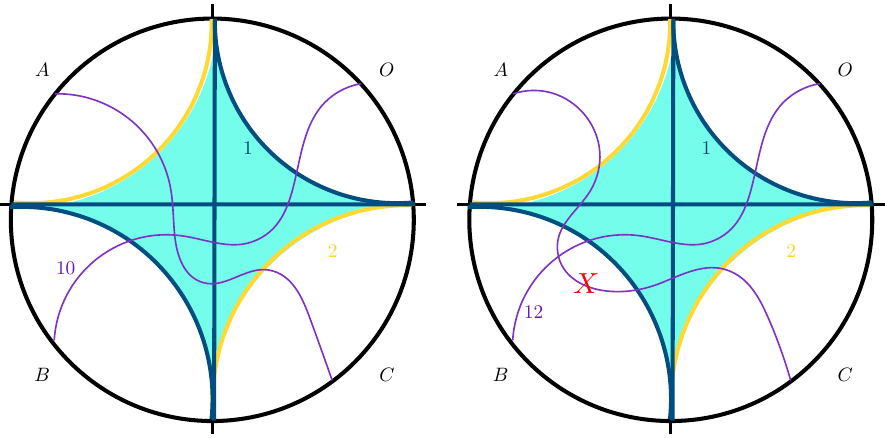
Figure 15 . L: shown is a 4-thread which crosses exactly a barrier of ten and can contribute to an optimal perfect tensor hyperthread configuration as a result of theorem 3. Such threads must have their vertex in the central light blue region as can be verified by comparing with the figure on the right. As such 4-threads are combed to the center of the